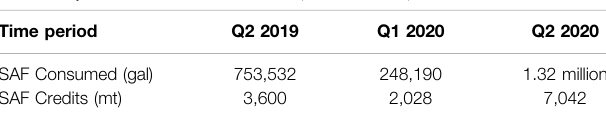
TABLE 1 | SAF consumed in California (Pedrick,